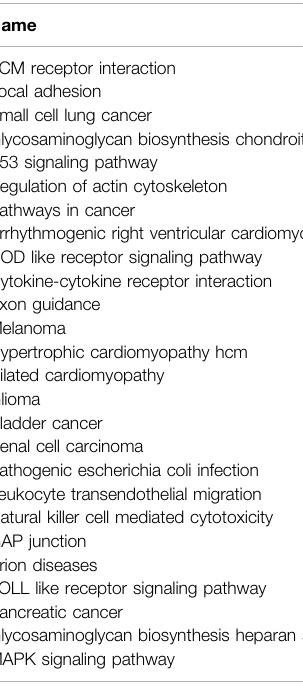
TABLE 3 | Signaling mechanisms associated with the risk